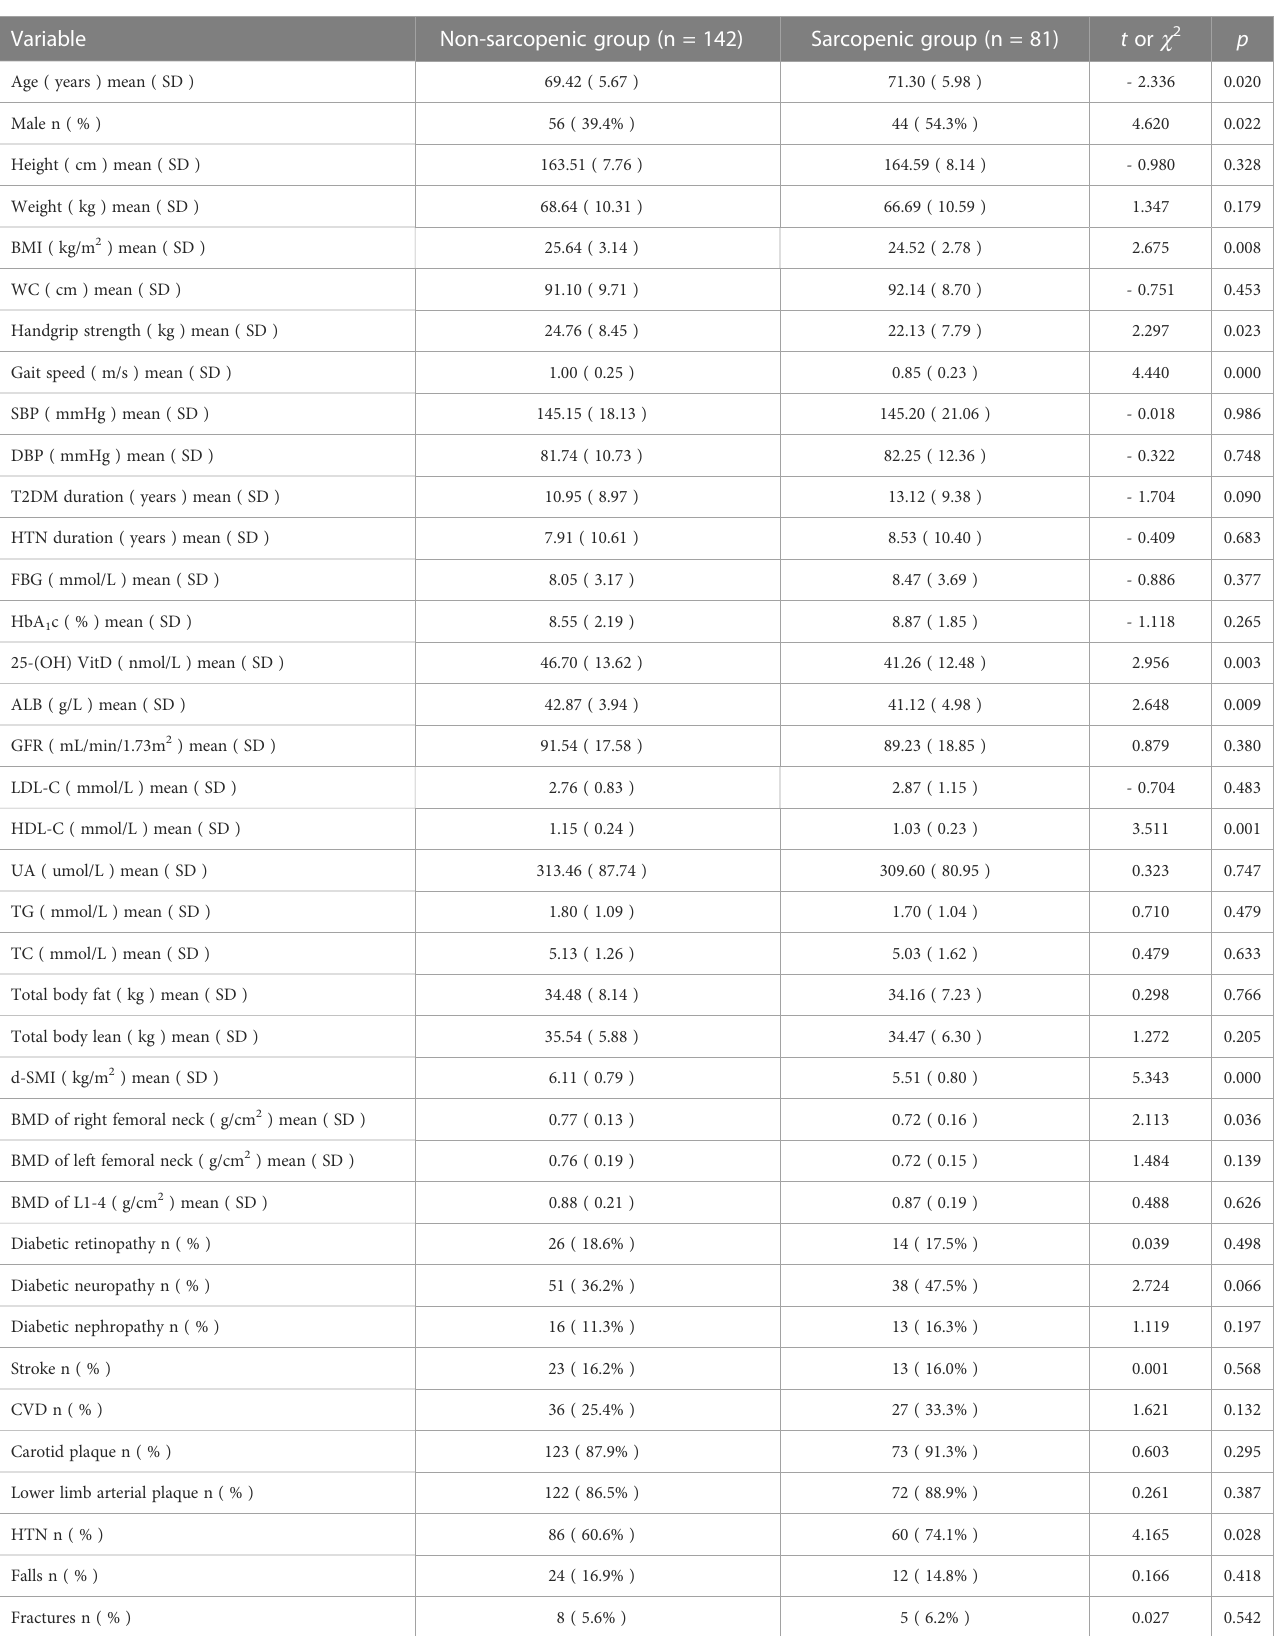
TABLE 1 Baseline characteristics of sarcopenia and non-sarcopenic